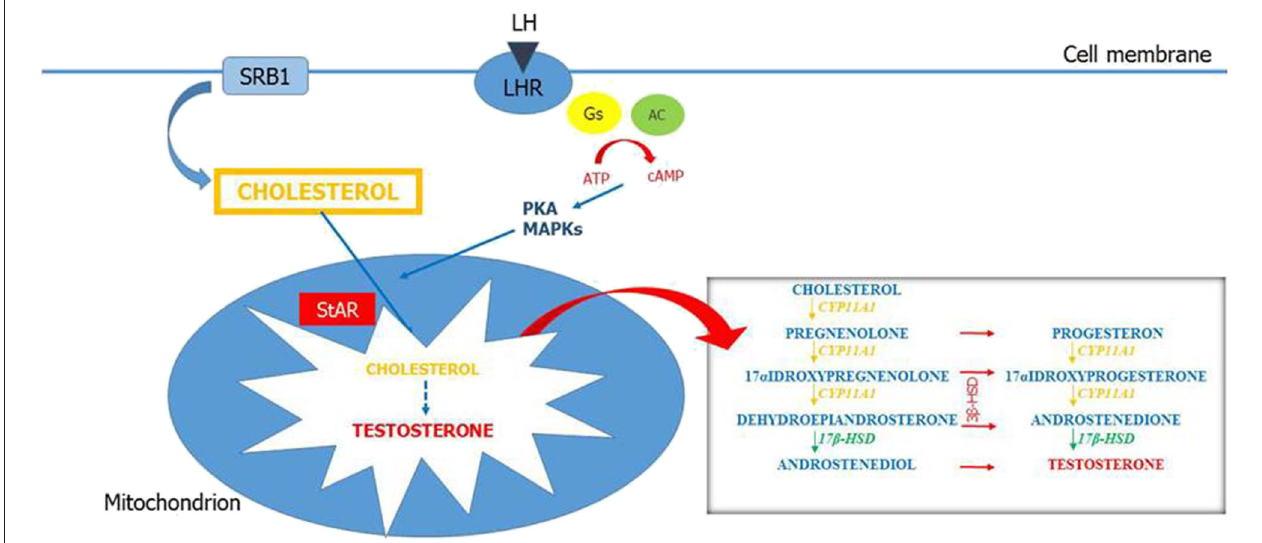
FIGURE 1 | Leydig cell steroidogenesis. LH binds to its receptors (LHR) on the Leydig cell (LC) membrane. This results in activation of Gs protein and adenylyl cyclase and increased concentration of intracellular cAMP. cAMP stimulates the mobilization and transport of cholesterol within the mitochondria in part by activating PKA and MAPK signaling. The first source of cholesterol for steroidogenesis is via uptake of cholesteryl esters from high-density lipoprotein (HDL) by the scavenger receptor SR-B1. Steroidogenic acute regulatory enzymes (StARs) regulate cholesterol transport from the outer to the inner mitochondrial membrane. At the inner mitochondrial membrane, cholesterol is converted into pregnenolone by CYP11A1 and pregnenolone is converted into testosterone by enzymes in the smooth endoplasmic reticulum (3 β -HSD, CYP17A1, and 17 β -HSD).